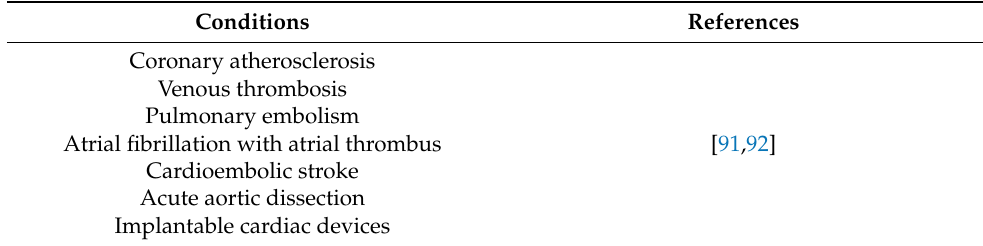
Table 2. Pathological conditions with increased D-Dimers levels (Almorad et al. and Miller et al. [91,92]).